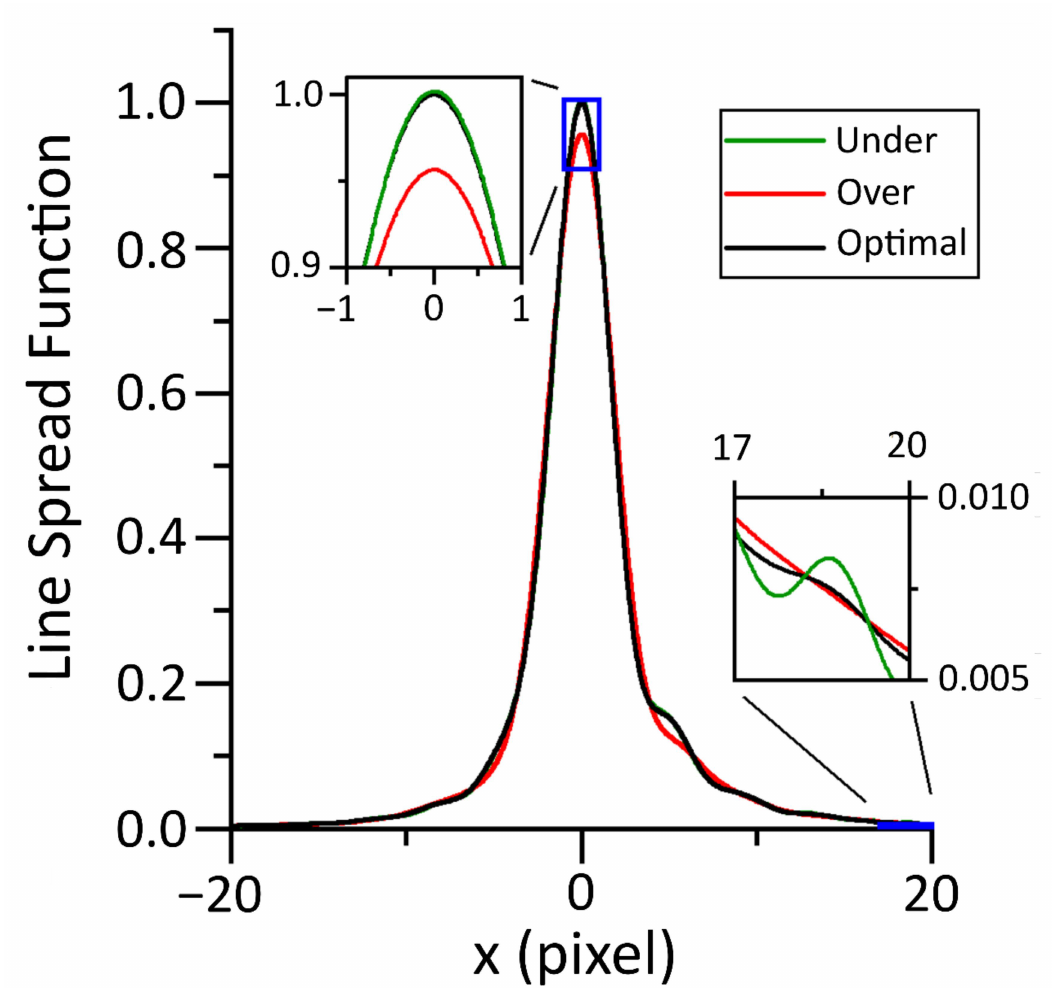
Figure 6. A frequency domain filter was used to smooth the knife edge data for differentiation. The parameters chosen for the filter effect the central peak and the low-amplitude wings of the distribution. The central peak and low-amplitude wings of the curve are shown zoomed in for